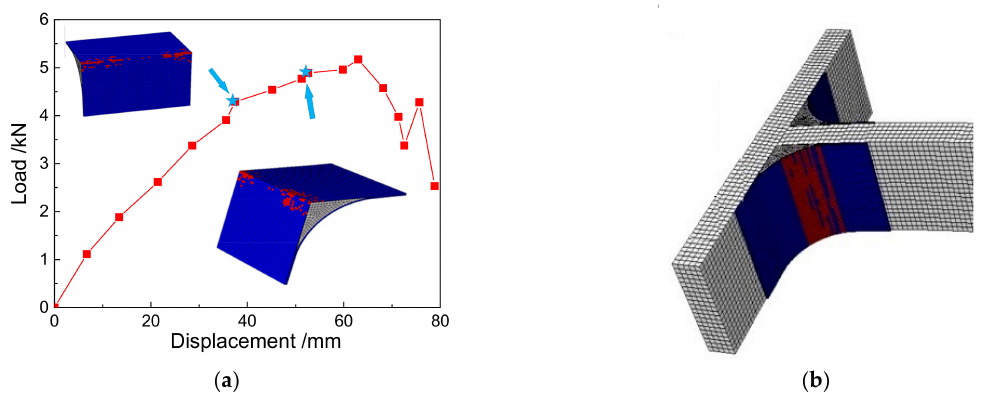
Figure 15. Results of ultimate bearing capacity of connectors ( a ) Load-displacement curve. ( b ) Fiber compressive failure of the lower connector.